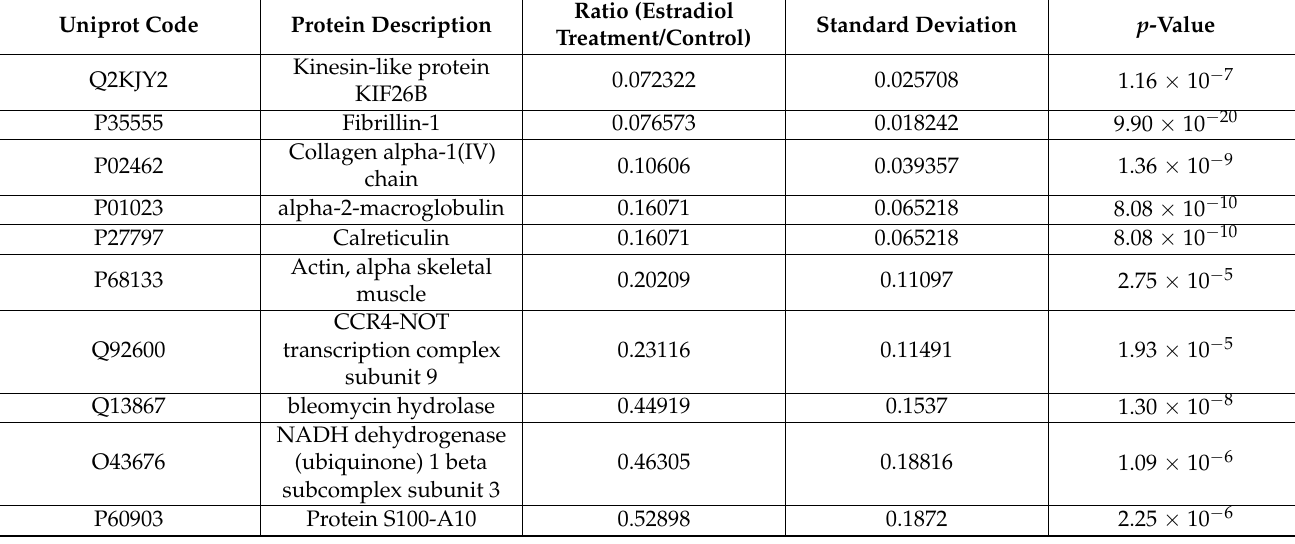
Table 1. Top ten downregulated proteins by Estradiol in MSCs and extracted using Proteome Discoverer Software. Uniprot Code